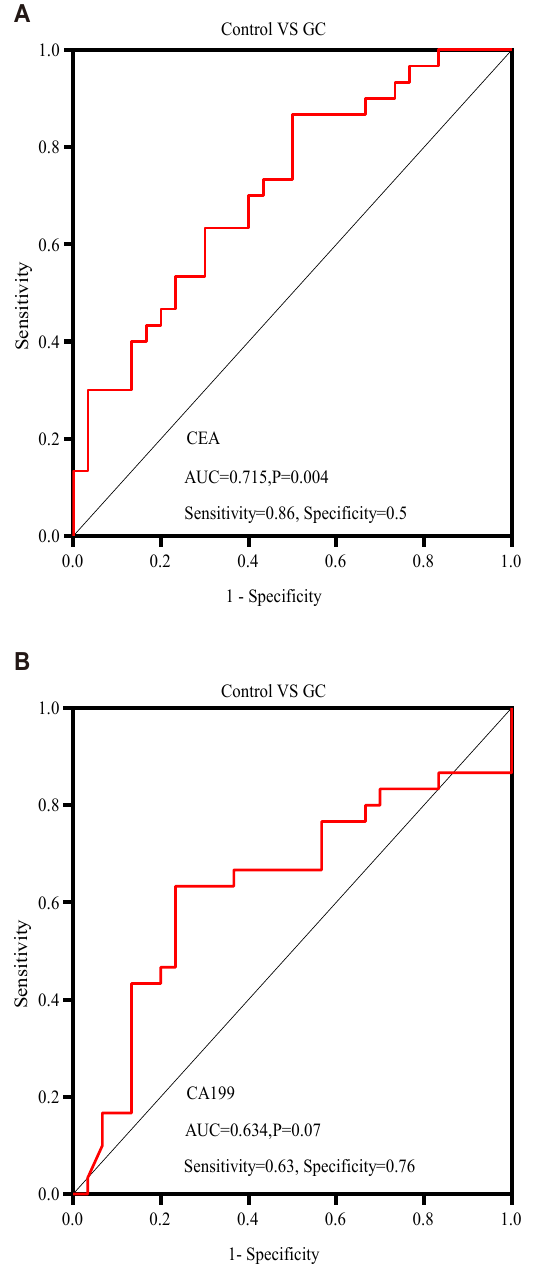
Figure 4: Receiver operating characteristic curves of the traditional serum biomarkers CEA and CA19-9. (A) ROC analysis for distinguishing between gastric cancer patients and healthy controls using CEA. (B) ROC analysis for distinguishing between gastric cancer patients and healthy controls using